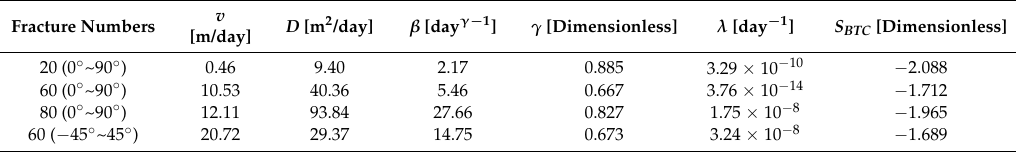
Figure 2. Breakthrough curves (BTCs) at the control plane x = 50 m for three different fracture densities ( a – c ); ( b , d ) have the same fracture density with different orientations. The BTC data (i.e., symbols) are simulated by HGS. The red line is the solution of the tempered time fADE (tt-fADE) model (10) and (11). The black line is a power law approximation to the late time decay in concentration. ( e ) shows the empirical linear relationship between the slope of the power-law decay in concentration and the time index γ in the tt-fADE model (10) and (11). Table 2. Best-fit parameters for the tt-fADE model (10) and (11) for discrete fracture networks (DFNs) with different fracture densities and orientation scenarios. In the legend, v denotes the effective velocity, D is the dispersion coefficient, γ is the time/scale index, β is the fractional-order capacity coefficient, λ is the truncation parameter, and S BTC stands for the late-time BTC slope in a log–log plot. Fracture Numbers v [m/day]